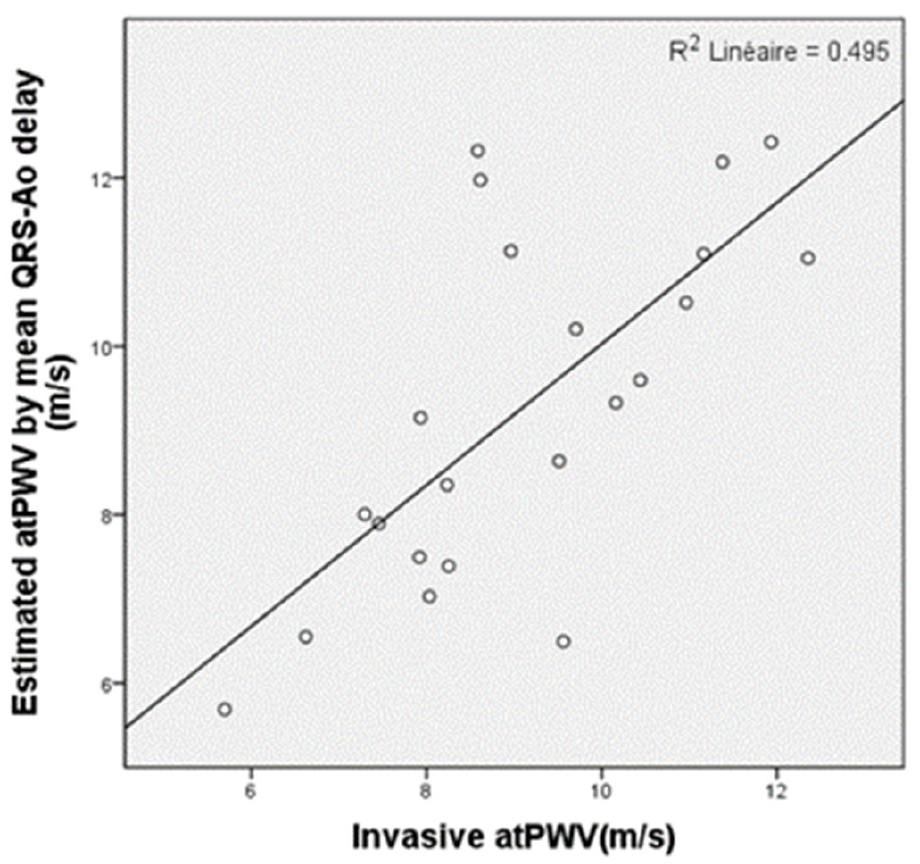
Figure 9. Correlation plot between invasive aorto-tibial PWV and estimated PWV using the mean time delay between the R-waves of the QRS and the aortic blood pressure wave.